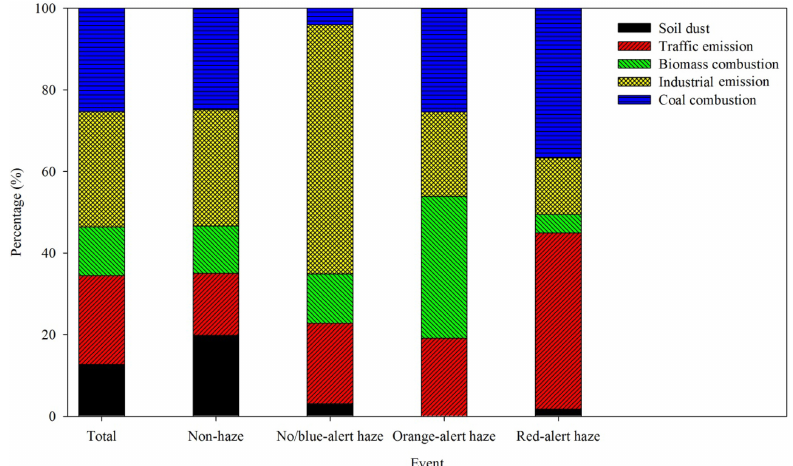
Figure 5. Comparison of source contributions (left to right) over the entire winter, during non-haze events, and during no/blue-alert, orange- alert, and red-alert haze